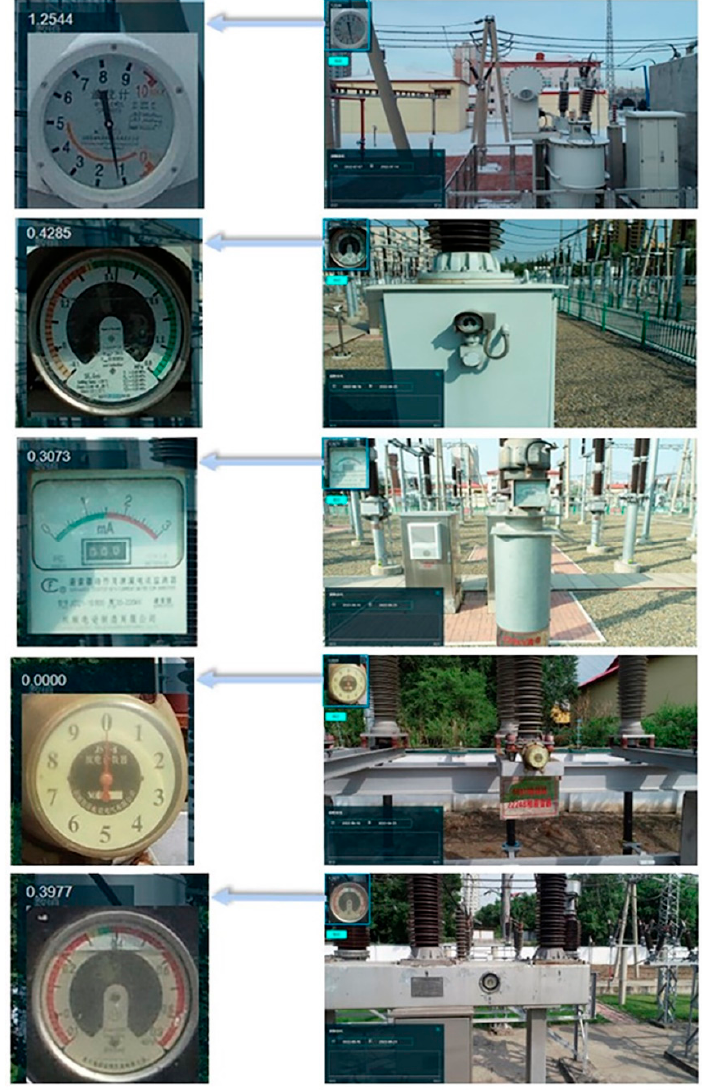
Figure 9. The results of the meter reading.